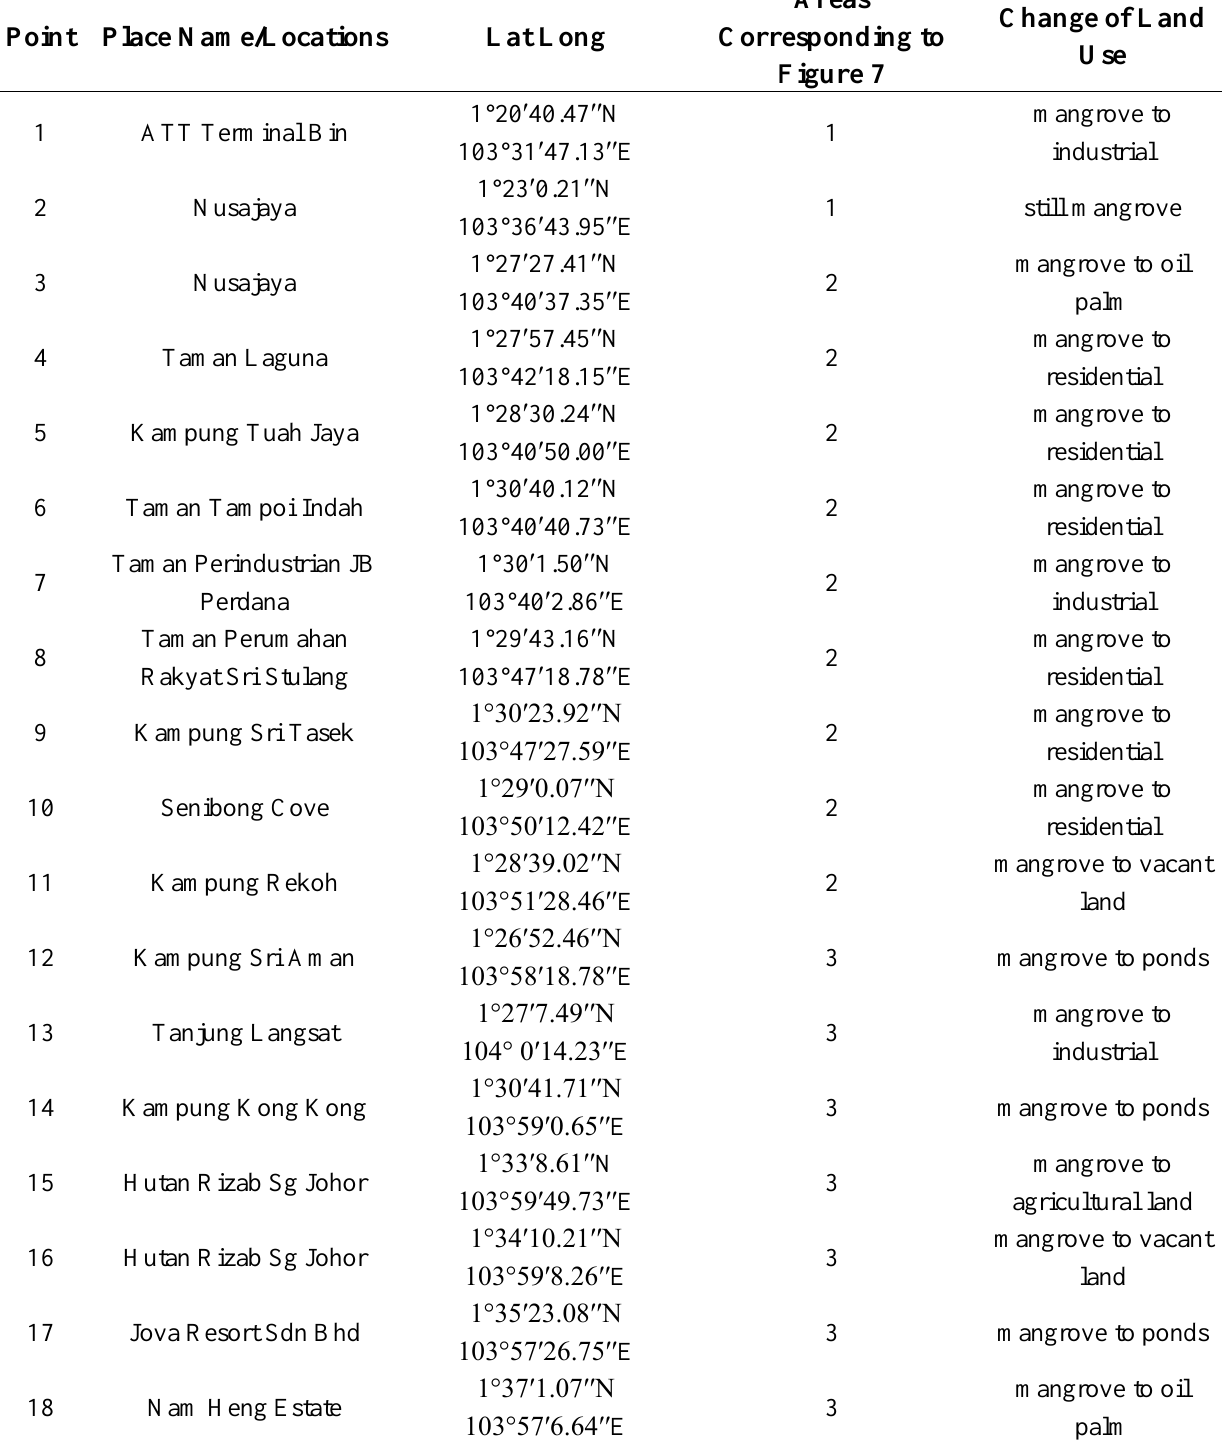
Table 6. Verification of changed mangrove areas as detected by satellite images with Google Earth images. Point Lat Long